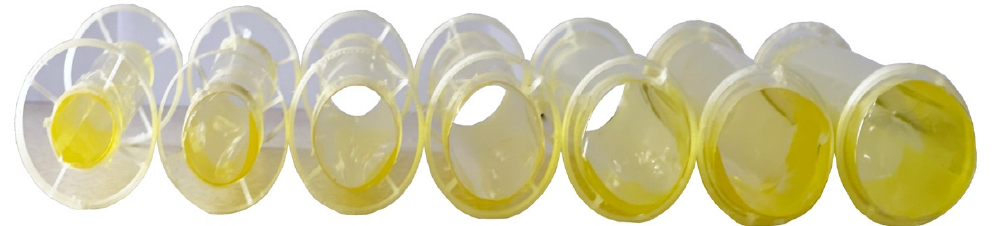
Figure 3. Constructed phantoms used for designing various void fractions.